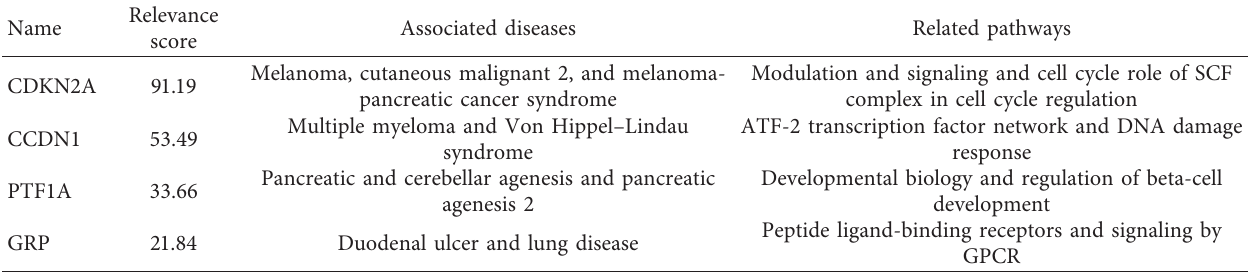
Table 5: Co-DEGs identified by SG-jNMF on